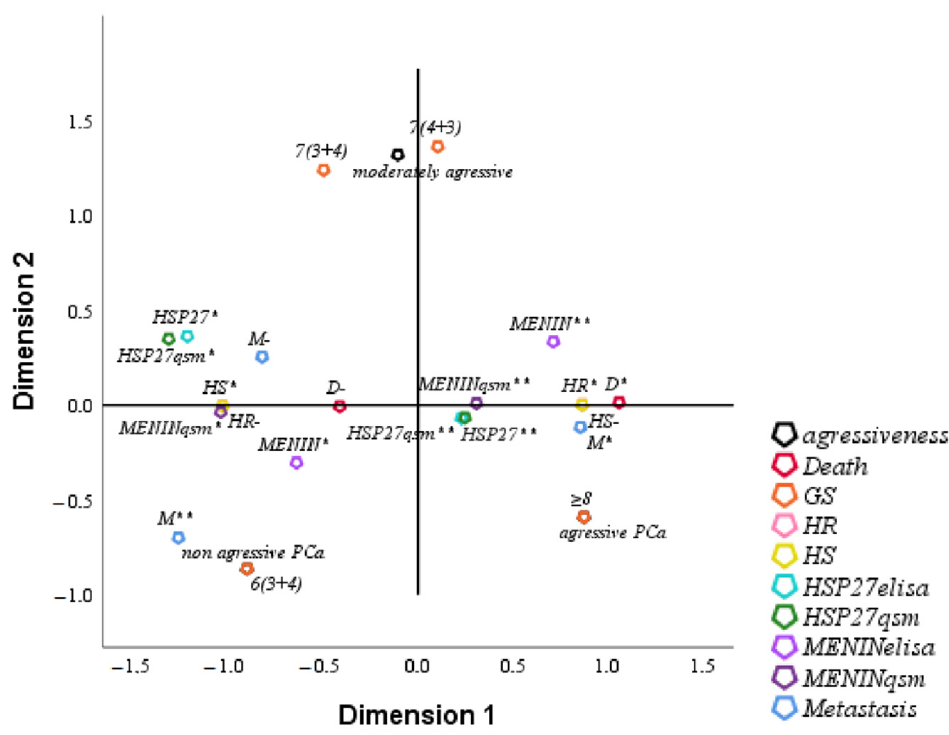
Figure 5. FCA of clinical parameters. M*: Metastasis, M-: No metastasis, M**: Recovery, D*: death, D-: Survival, HSP27**: over expression of HSP27 in serum, HSP27qsm**: over expression of HSP27 in tissue, Menin**: over expression of Menin in serum, Menin qsm**: over expression of Menin in tissue, HR*: Hormone resistance, HR - : No hormone resistance, HS*: Hormone sensitivity, HS - : No hormone sensitivity.